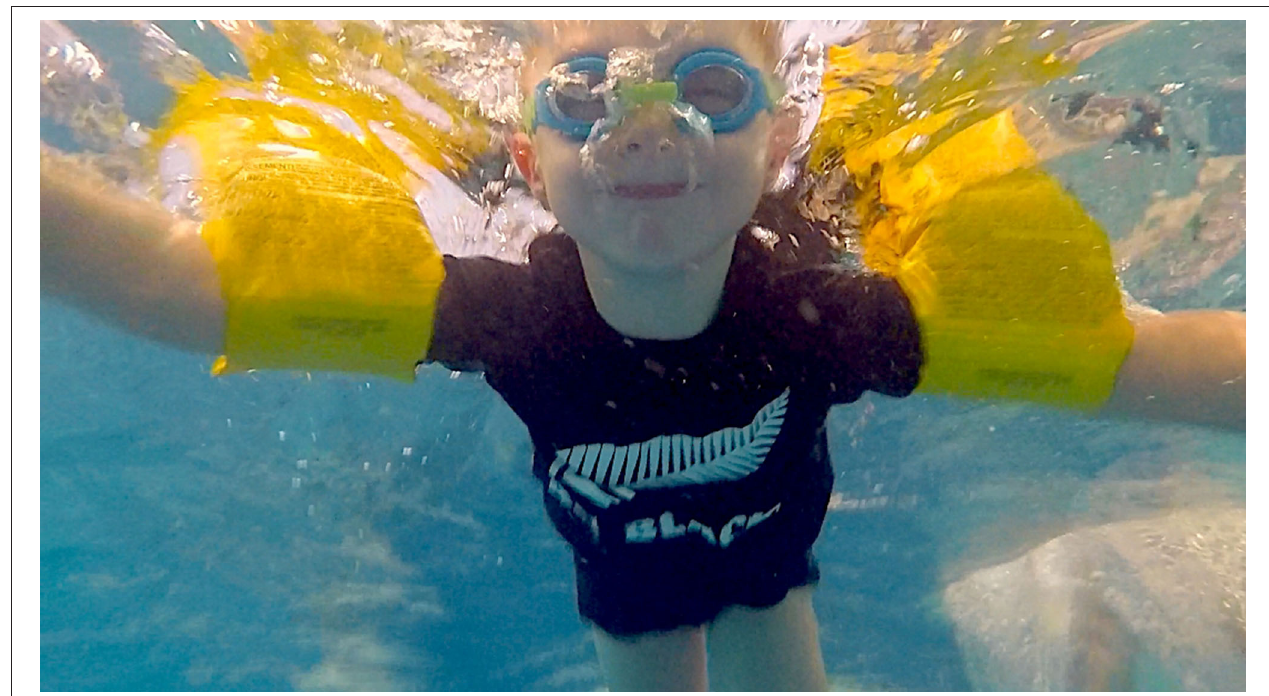
FIGURE 1 | A child wearing water wings while